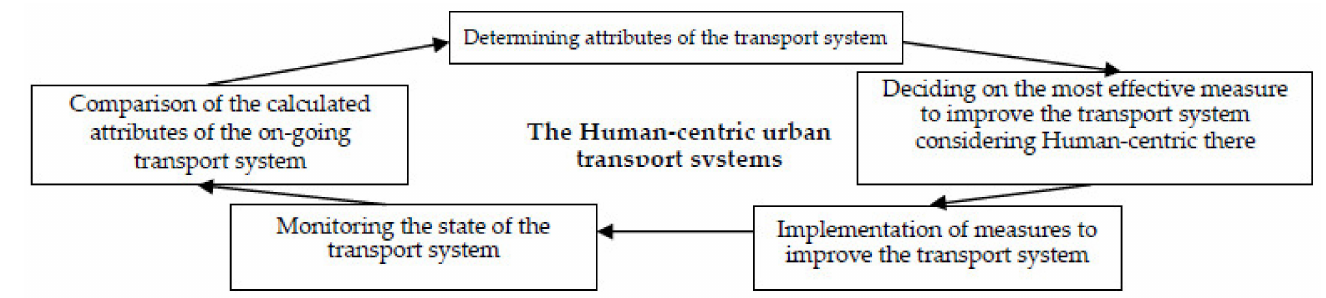
Figure 1. Stages of human-centric urban transport systems.